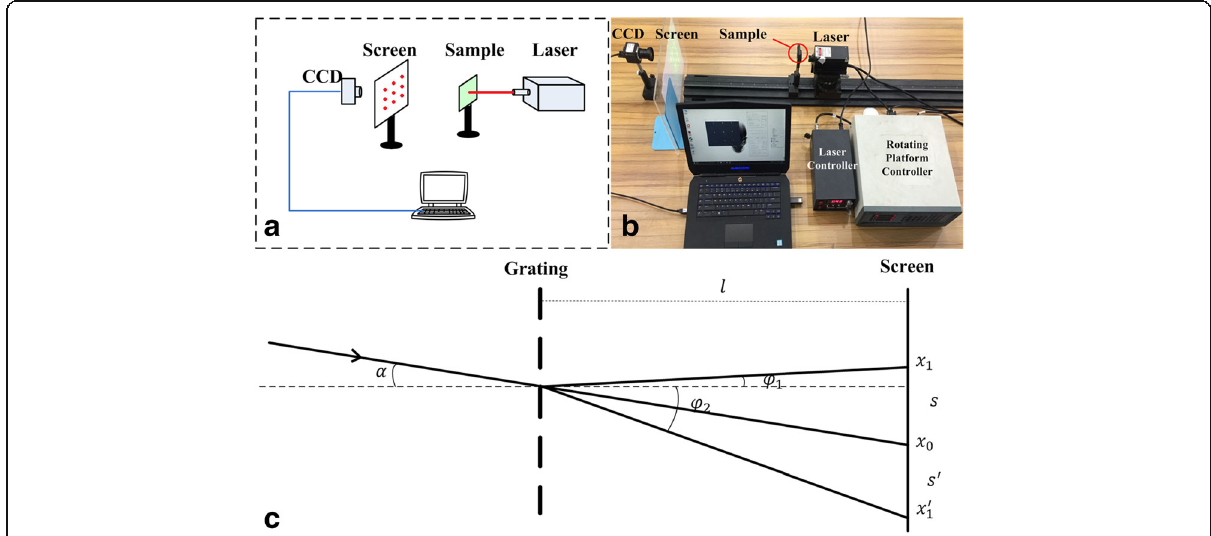
Fig. 2 The principle and test system for the MODF motion parameter. a system diagram. b System setup. c Testing principle of displacement and